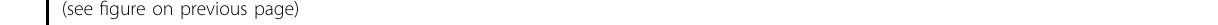
Fig. 7 Loss of FXR increases renal damage in the sham and I/R injury mice after 7 days. At 7 days after I/R, kidney samples were collected for measurements. A Protein levels of p62, LC3, Bcl2, Bax, and FXR were detected by immunoblotting. B The relative protein levels are shown, and the values for the WT-Sham group were set to 1 ( n = 3 – 4). C Renal cortical tissues were collected for hematoxylin and eosin (H&E), periodic acid-Schiff (PAS) and Sirius Red staining to examine histology and for immunohistochemistry to examine the expression of F4/80, 3-NT, and 4-HHE. Computer- based morphometric analysis is shown (right bar graph, n = 6 in each group). All values are presented as the mean ± SD. Statistical signi fi cance was measured using one-way or two-way ANOVA with the Bonferroni post-test. * P < 0.05, ** P < 0.005, # P < 0.05.